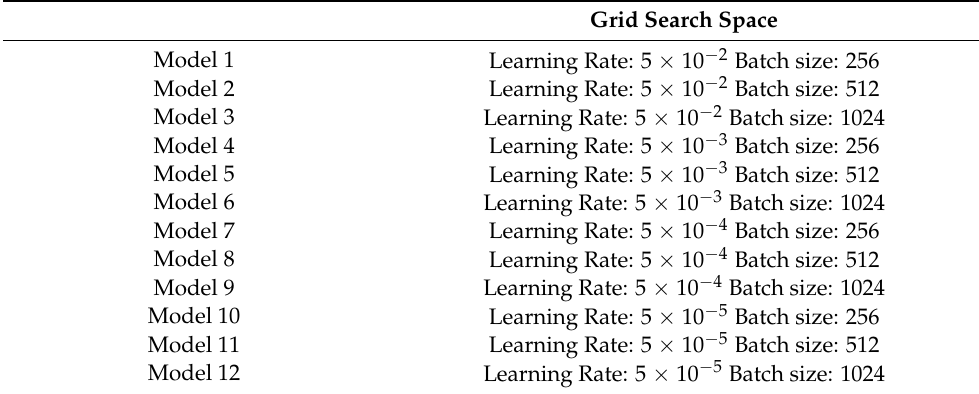
Table 1. Grid search space of pre-trained